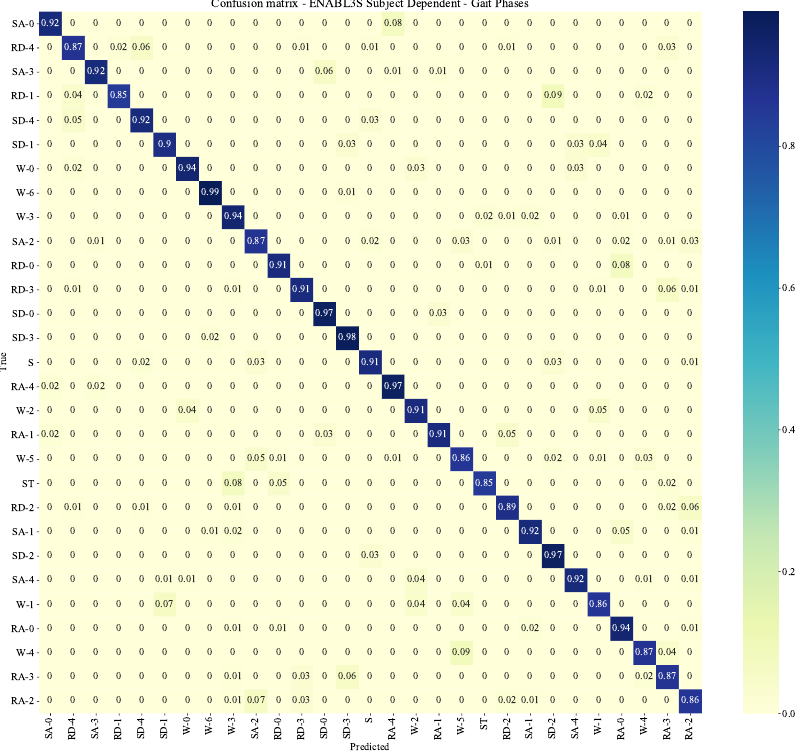
Figure 11. Confusion matrix for the ENABL3S subject dependent scenario on the CNN-LSTM configuration for the gait phases